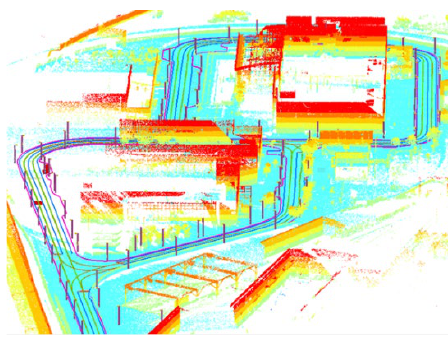
Figure 1. HD Map with point cloud